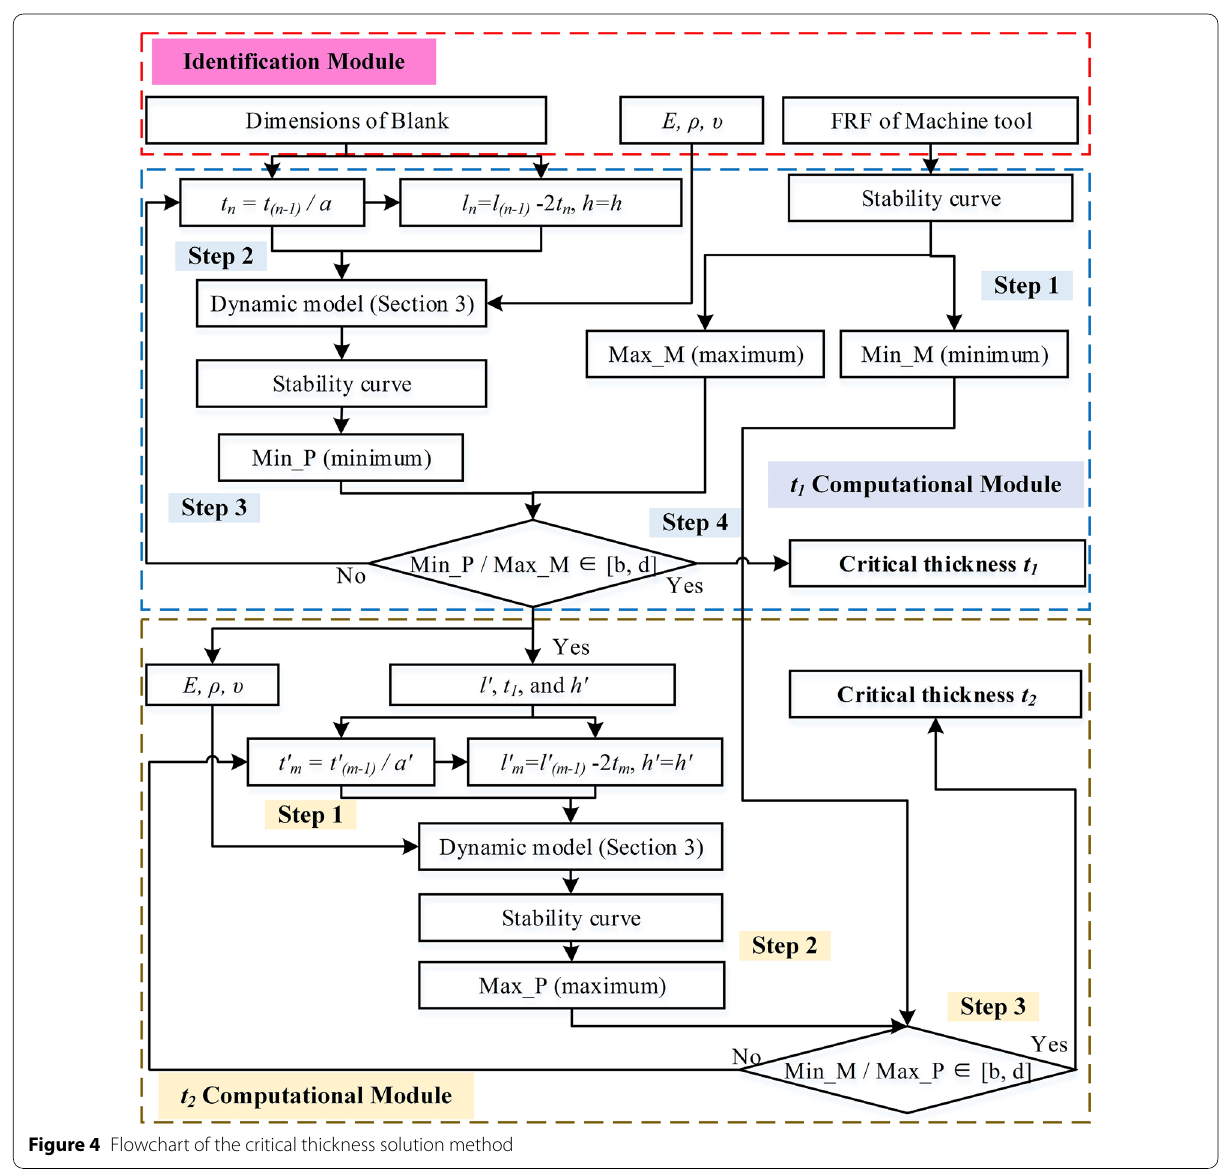
Figure 4 Flowchart of the critical thickness solution method